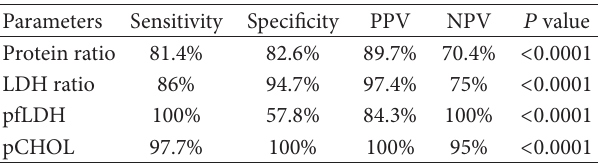
T 1: Diagnostic comparison of PF parameters with clinical